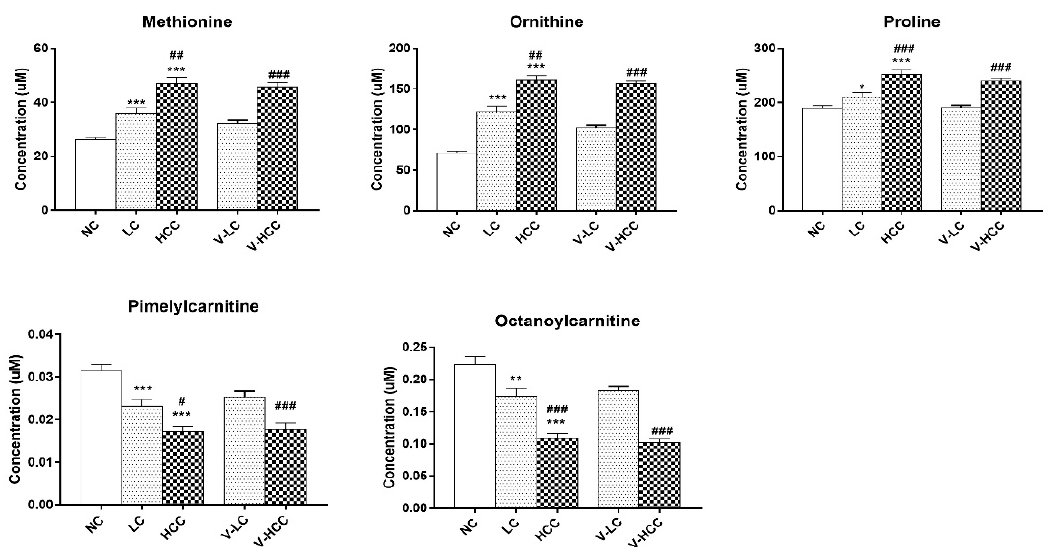
Figure 2. Comparisons among metabolic biomarkers. Bar graphs represent the concentration of individual metabolic biomarkers, namely methionine, ornithine, proline, pimelylcarnitine, and octanoylcarnitine. All the metabolites have VIP scores > 1.0. FDR-adjusted p -values * < 0.05, ** < 0.001, or *** < 0.0001 represent a statistical significance compared with NC group. FDR-adjusted p -values # < 0.05, ## < 0.001, or ### < 0.0001 represent a statistical significance with LC or V-LC group. NC, LC, and HCC belong to the training set. V-LC and V-HCC belong to the test set. V-LC, liver cirrhosis in